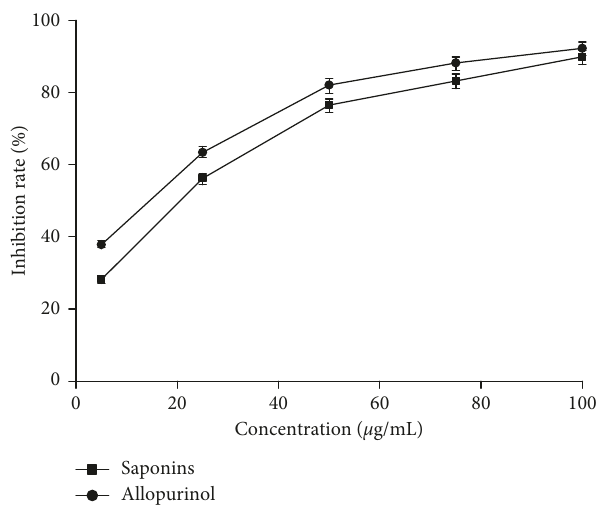
Figure 3: Inhibition of xanthine oxidase activity as a function of S. mukorossi saponins and allopurinol concentrations.